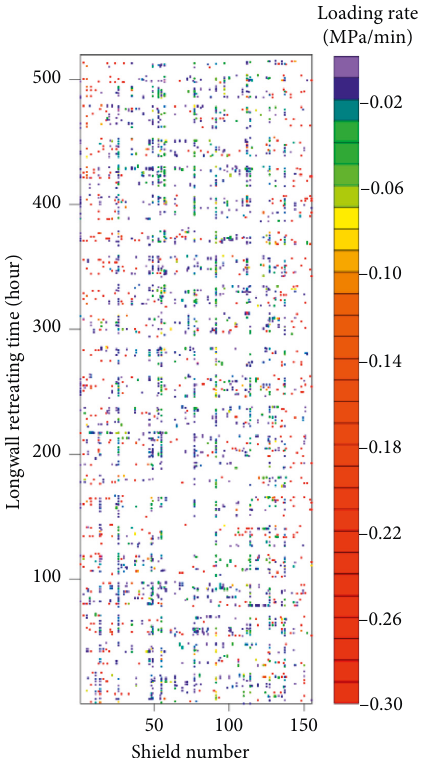
Figure 20: Change of loading rate with longwall retreating time in Panel LW 22306 of Bulianta mine. A negative loading rate denotes the decrease of leg